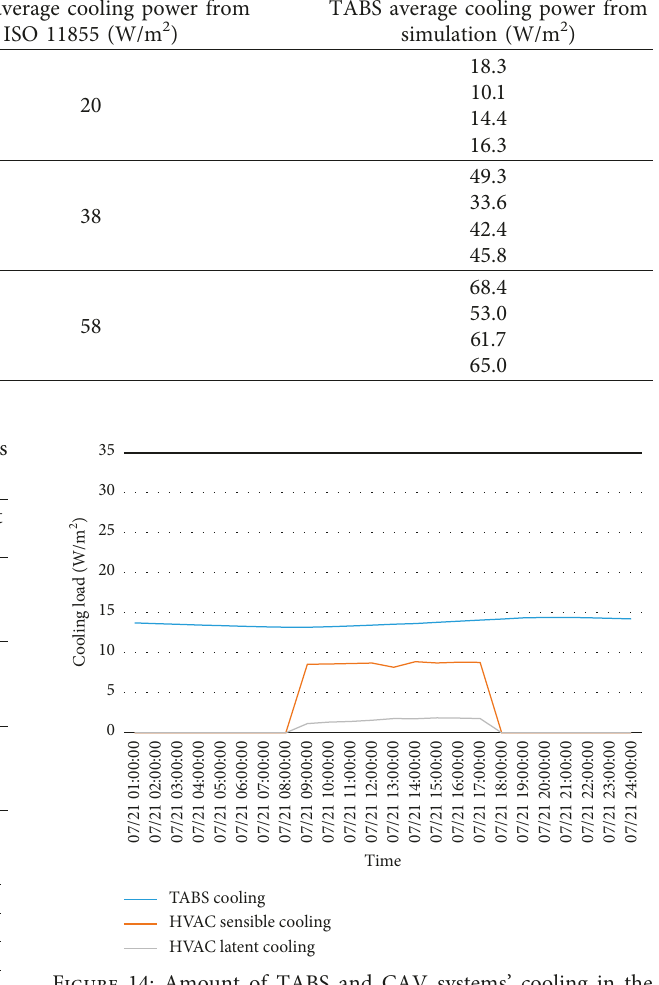
Figure 14: Amount of TABS and CAV systems’ cooling in the office